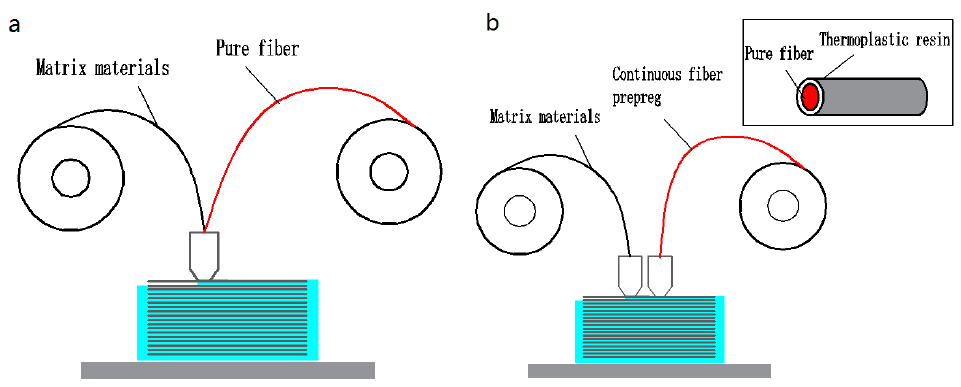
Figure 1. ( a ) The “co-extrusion” printer. ( b ) The “independent extrusion”